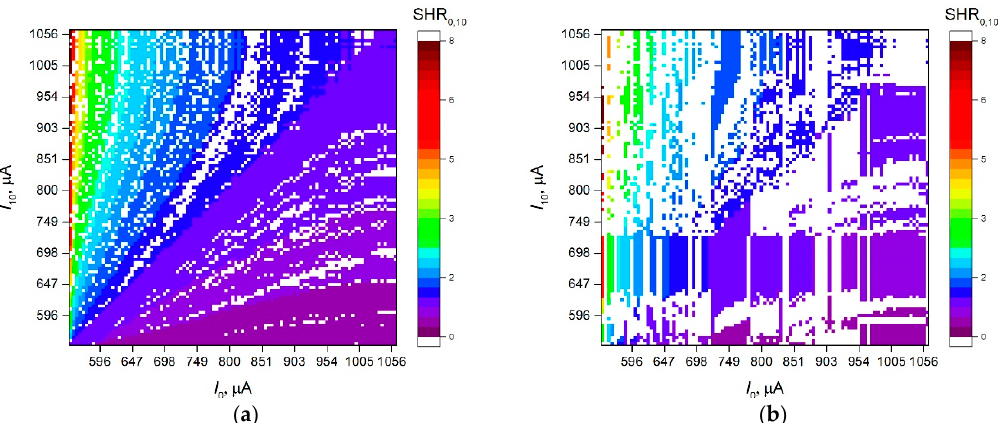
Figure 17. The synchronization distribution SHR 0,10 in the regions of currents I 0 and I 10 with ( a ) s o = 0 V and ( b ) s o = 0.1 V. For all cases, I ON = 725 µA, I OFF = 1036 µA, s r = 0.3 V, s m = 0.207 V, η th =90%, U n = 80 µV, and the class C 94 is the input.